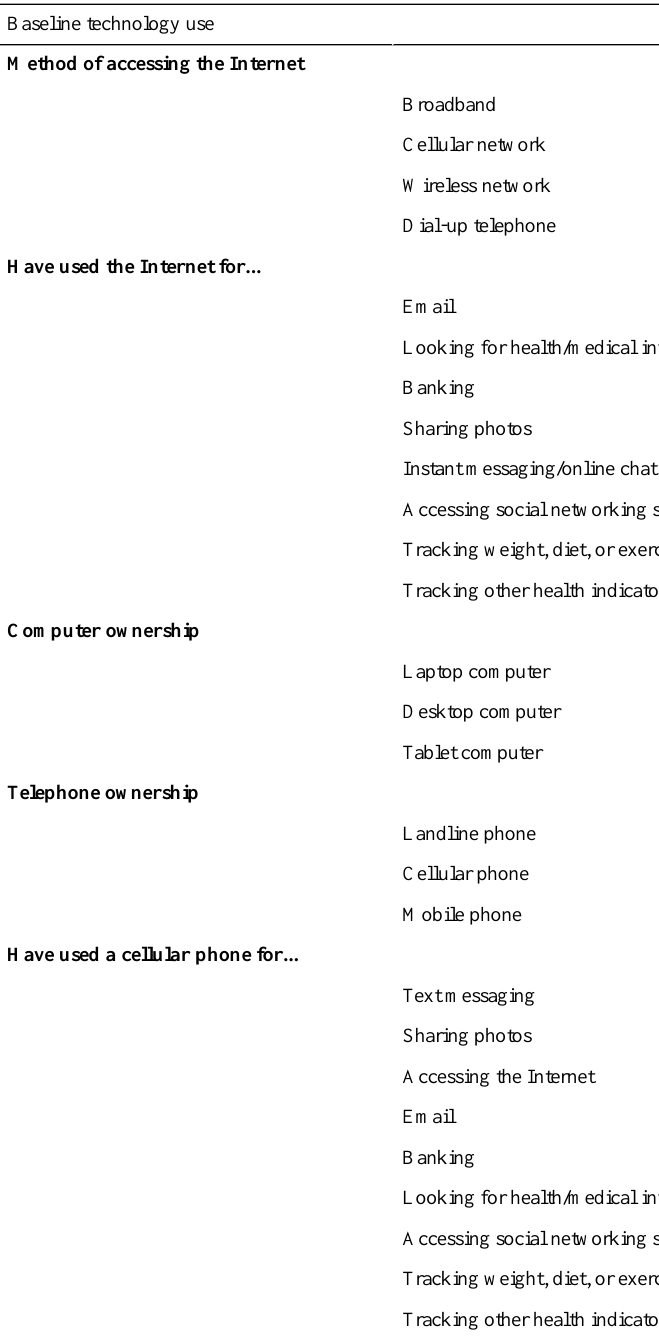
Have used the Internet for...